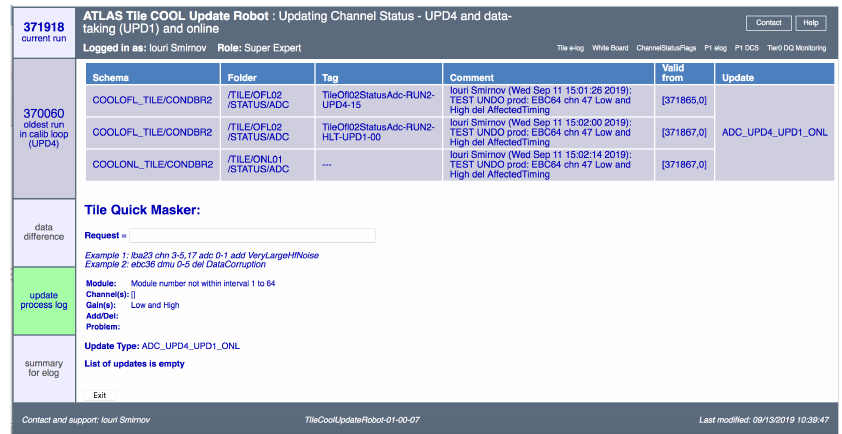
Fig. 4. TileCalibWeb (Robot) tool for Conditions DB updates.